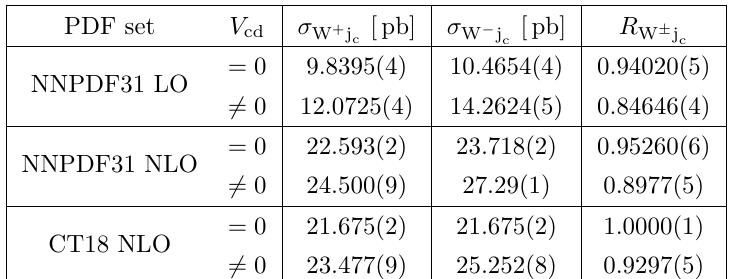
, pp → W − j , and their ratios at the LHC at c c